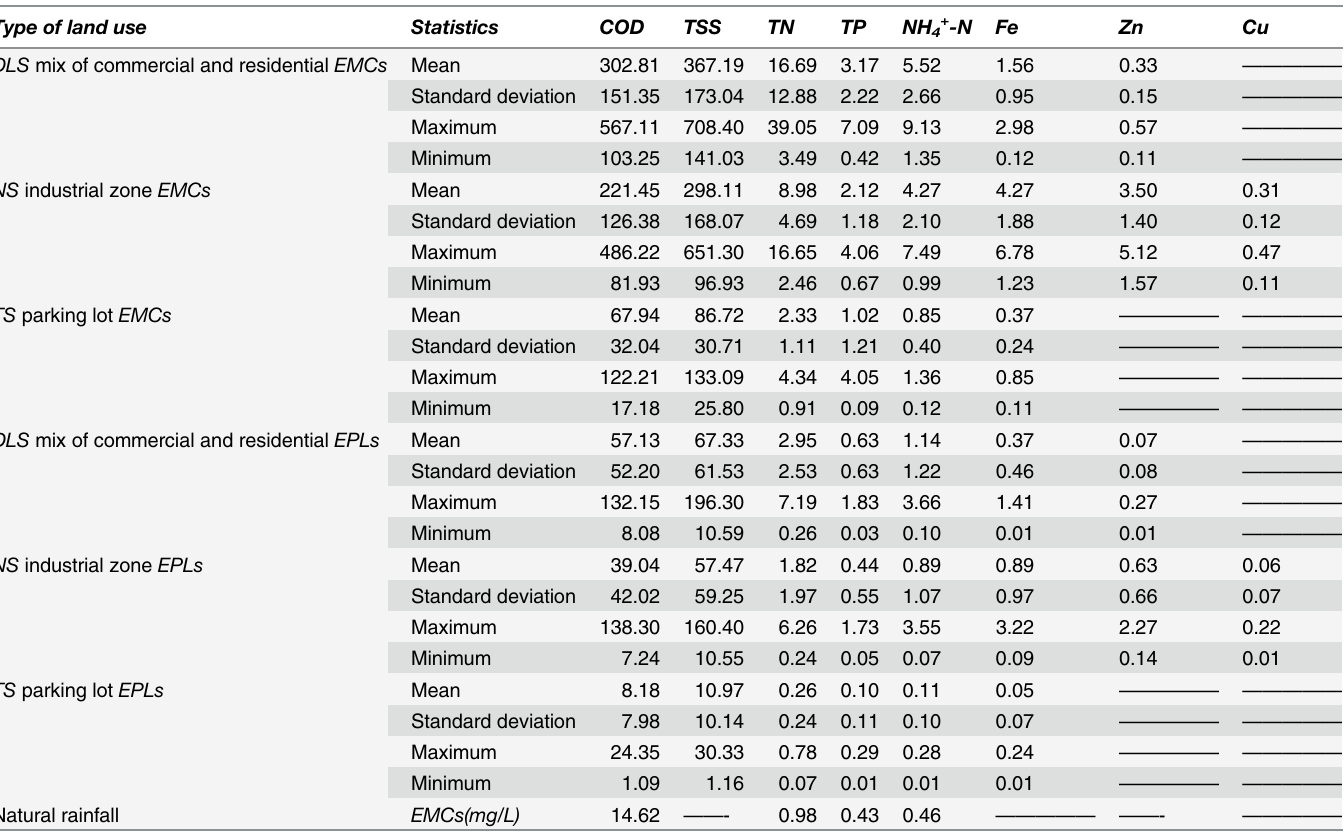
Table 3. Basic statistics of runoff pollution EMCs and EPLs in all storm